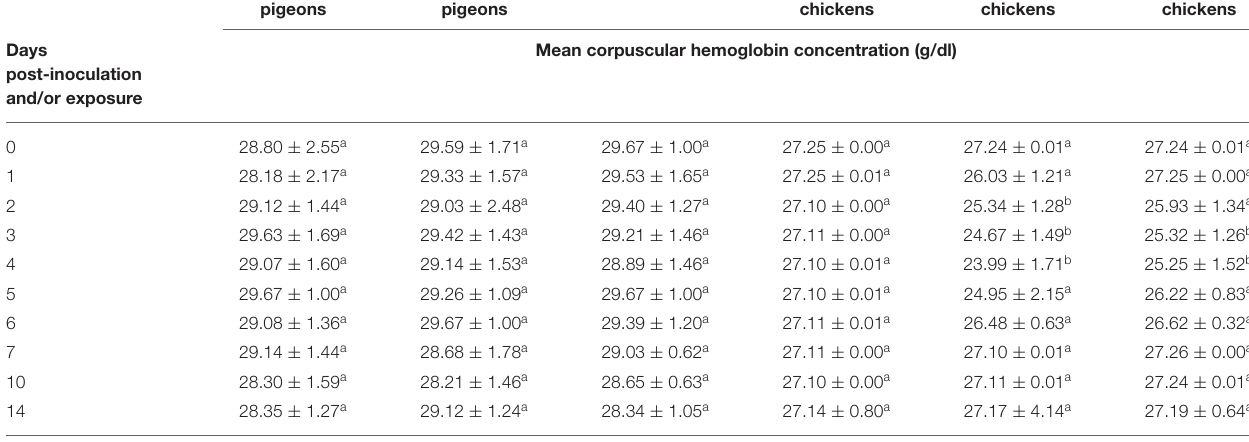
Uninoculated Inoculated Sentinel pigeons Uninoculated pigeons pigeons